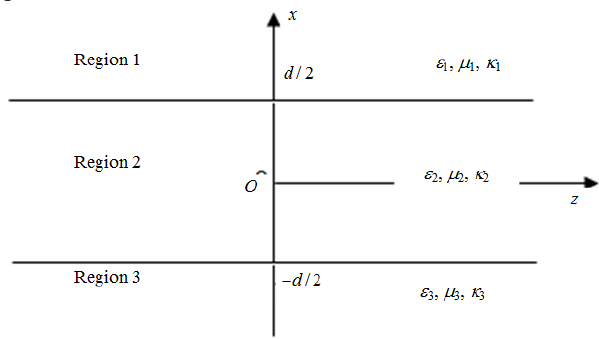
Fig. 1 Schematic diagram of three-layer waveguide structure having chiral